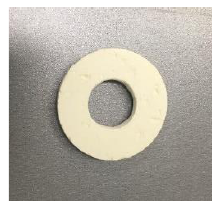
Figure 2. Picture of immobilised g -C 3 N 4 catalyst on alumina substrate.